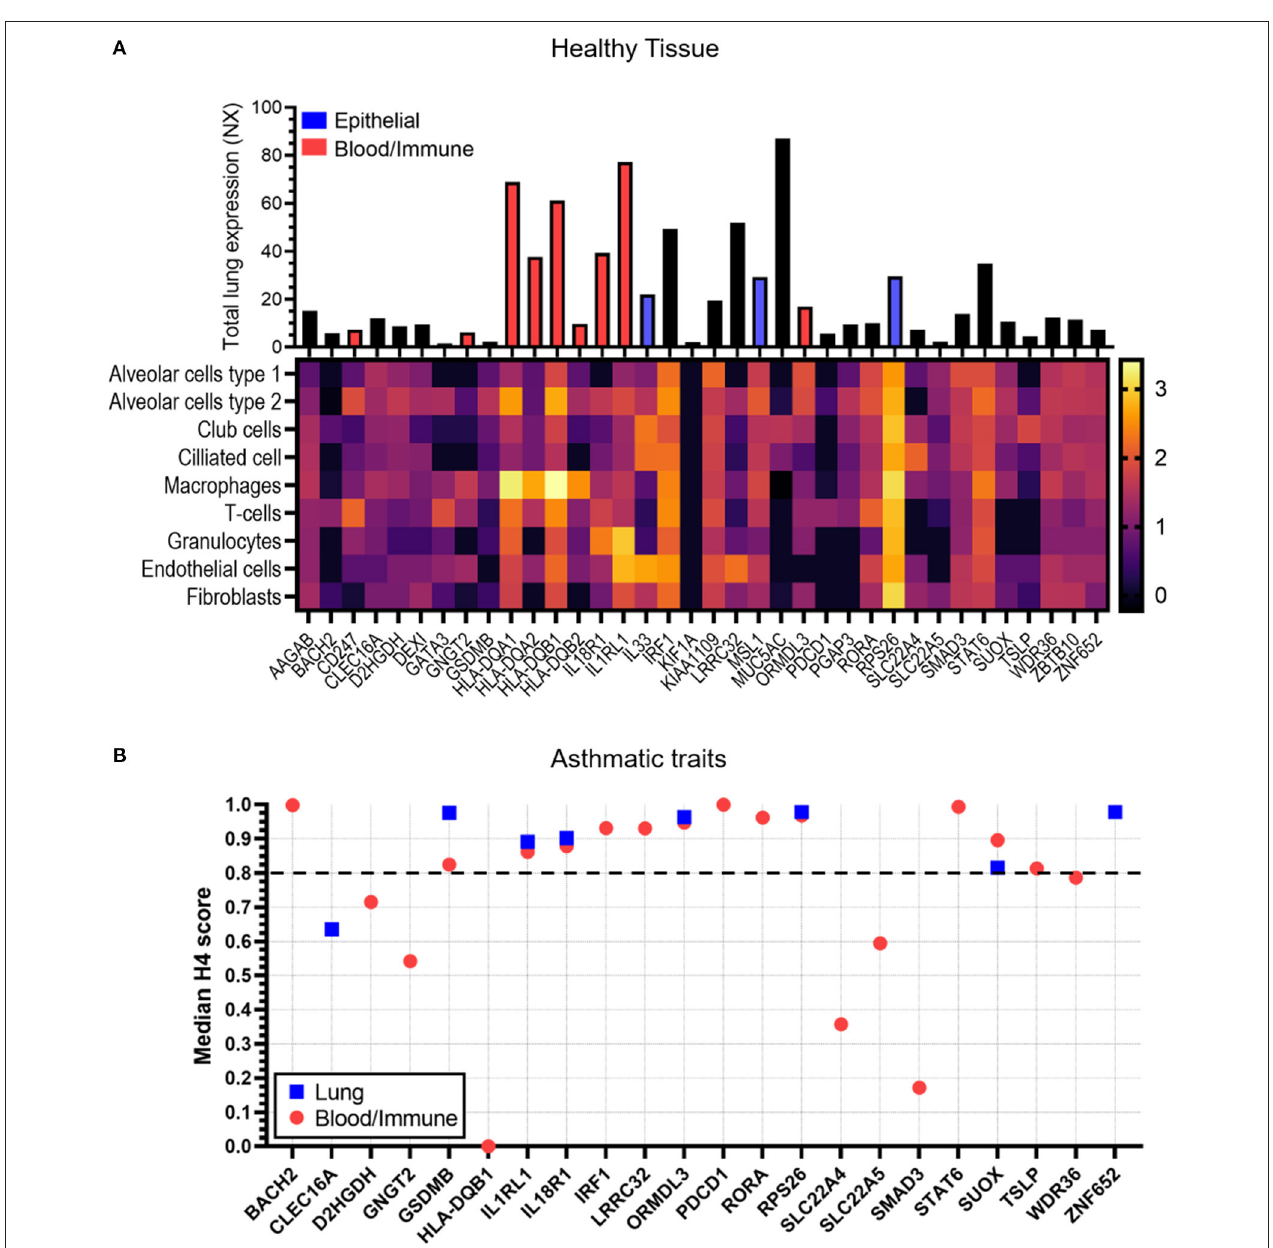
FIGURE 4 | Tissue expression and colocalization analysis of candidate genes. (A) Data was taken from the Human Protein Atlas for both total lung RNA expression scores (bar chart, NX) and single cell RNA expression [heatmap, log 10 (median transcripts per million protein coding genes)] in healthy tissue. Bar directly corresponds to gene in heatmap. The Human Protein Atlas was also analyzed for genes which showed enriched/enhanced gene expression in epithelial cells (blue bar) and blood/immune cells (red bar) compared to other cell types. A full list of enriched/enhanced tissue and cell gene expression data per gene is available in Supplementary Table 2 . No data was available for FLG and therefore has not been shown. (B) Co-localization analysis (H4 scores) data was taken from the Open Target Genetics (OTG) platform for lung (blue squares) or blood/immune cells (red circles) in studies with the asthma trait (exclusive). Scores represent evidence of association between candidate gene, specific tissue and asthma trait. A higher score indicates greater association. Dotted line shows cut off value of 0.8. Candidate genes AAGAB, CD247, DEXI, FLG, GATA3, HLA-DQA1/A2, B2, IL33, KIF1A, KIAA1109, MSL1, MUC5AC, PGAP3 , and ZBTB10 had no association data for lung/blood/immune cells/tissue in OTG and therefore have not been